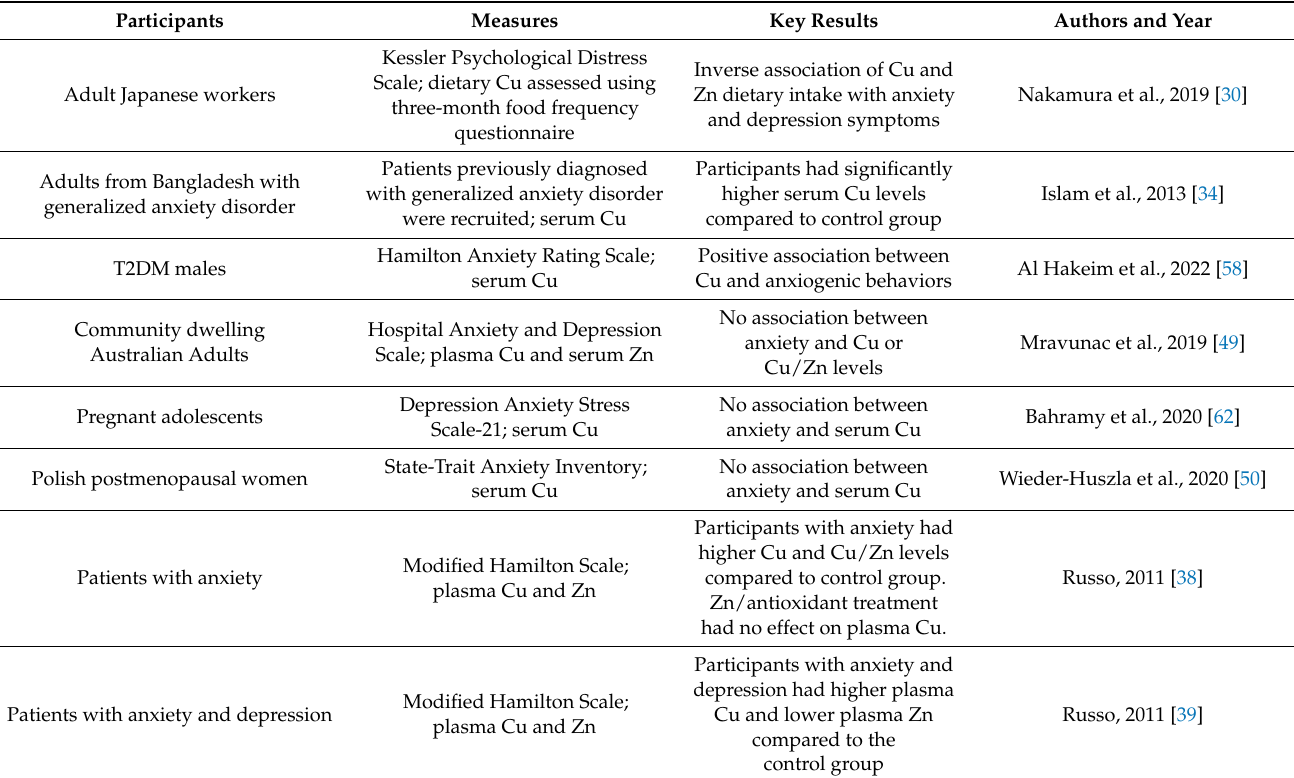
Table 2. Summary of clinical evidence for the relationship between copper (Cu) and